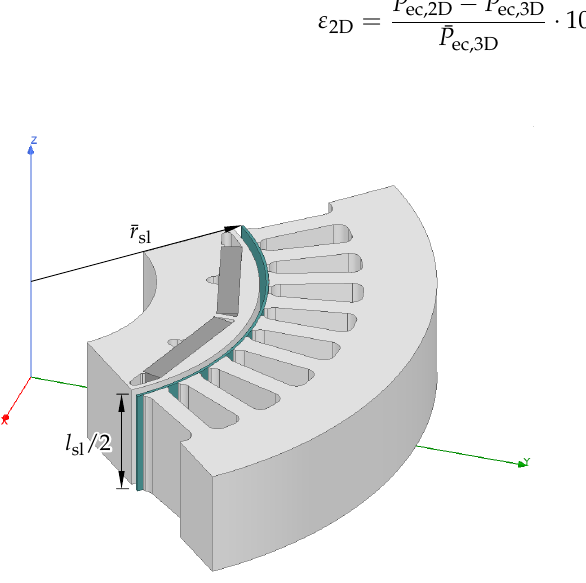
Figure 6. The 3D AED model used for the calculation of ¯ P ec,3D in the sleeve.